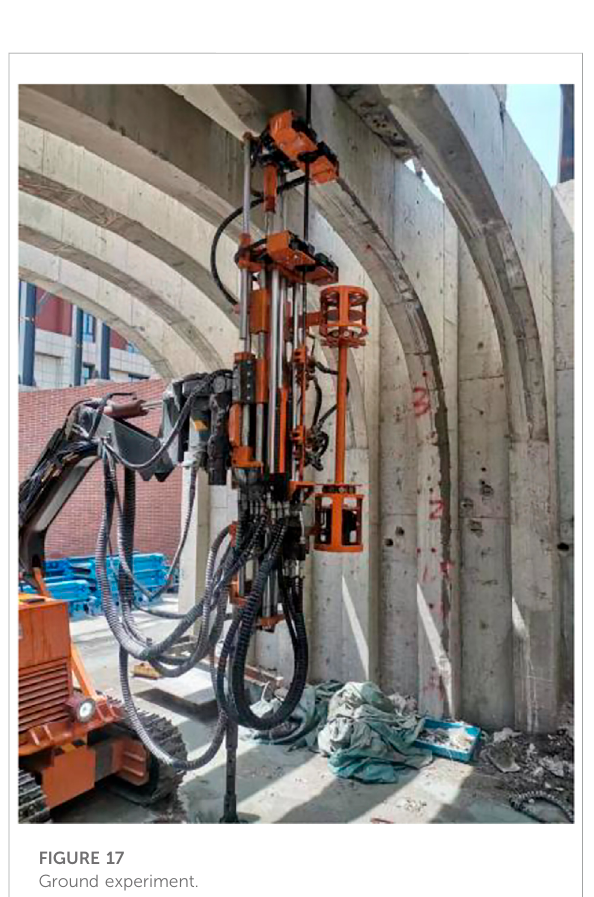
FIGURE 17 Ground experiment.